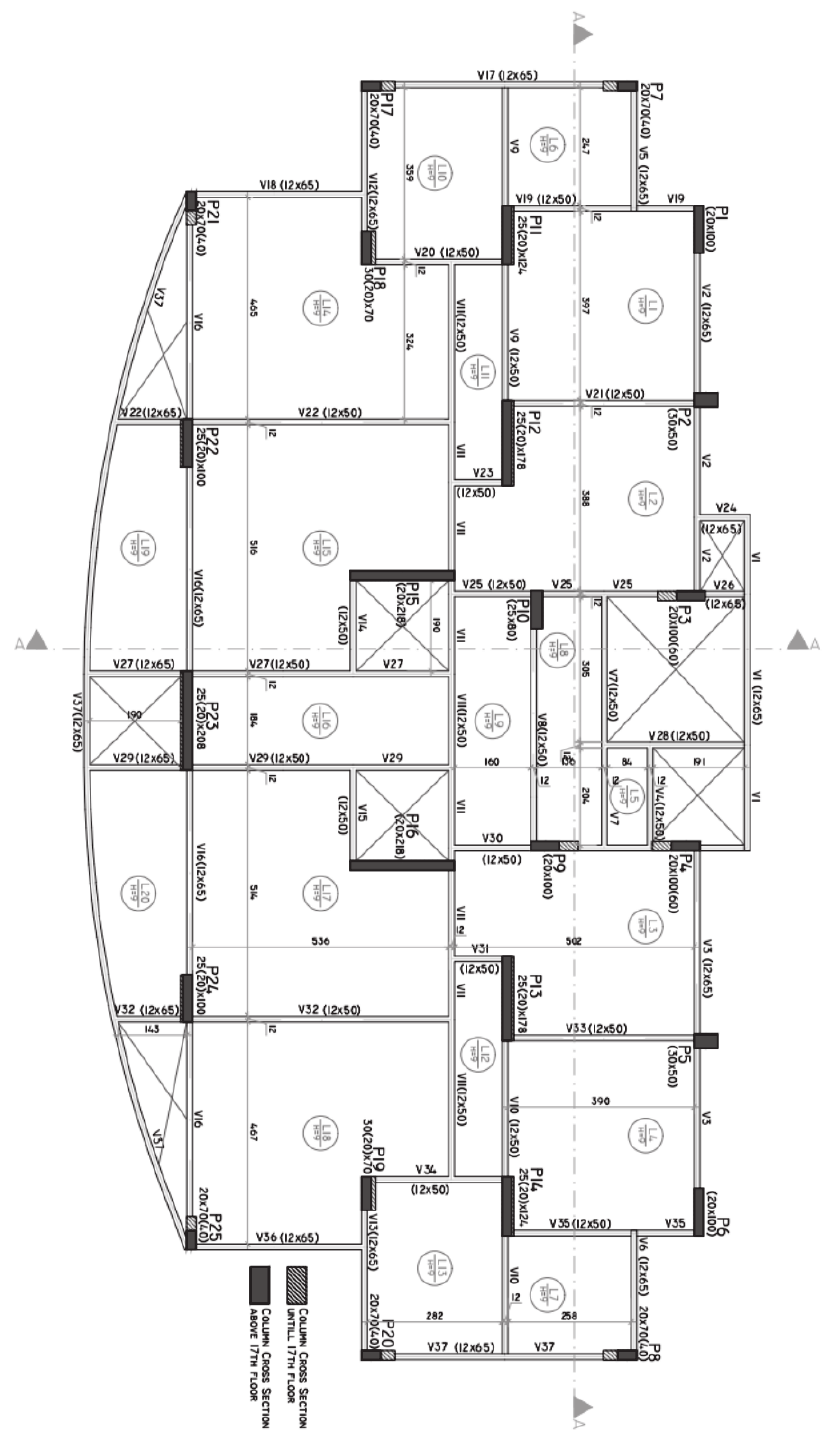
Plan view of floors 01 -